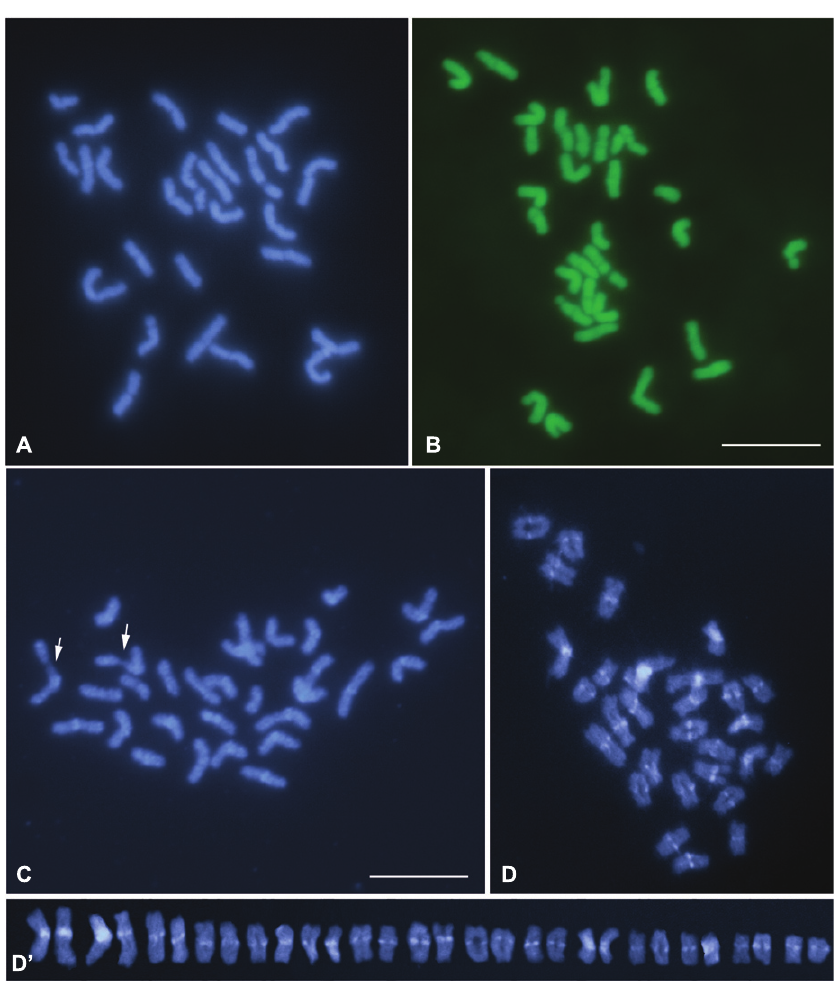
Fig. 1, A-D’. Mitotic plates of Hydra magnipapillata after HOECHST staining ( A ) and Quinacrine staining ( B ). No banding pattern is visible. Mitotic plates of Hydra magnipapillata after DAPI staining ( C ) and C- banding/ DAPI staining ( D, D’ ). DAPI-positive signals are sometimes visible in the centromeres; arrows indicate gaps in the 1 st chromosome pair; ( D’ ) Karyogram. Bars = 10